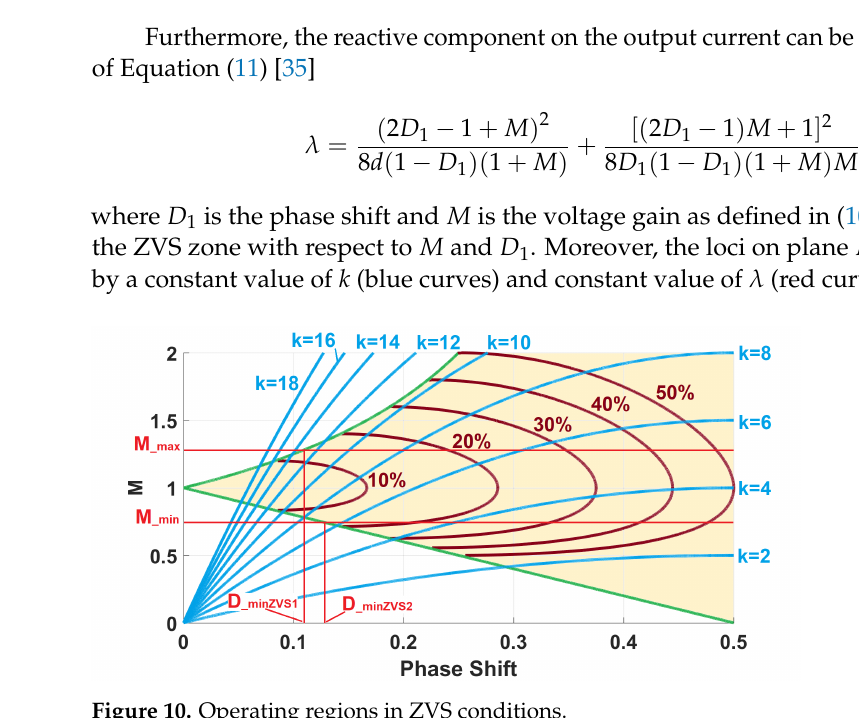
Figure 10. Operating regions in ZVS